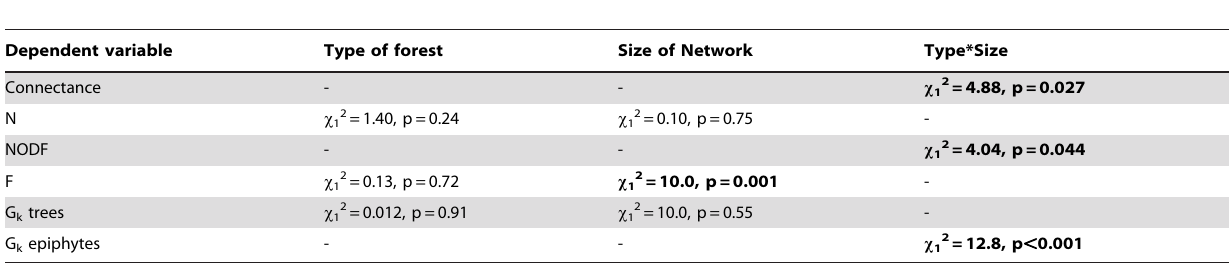
Chi-square values are the results of Likelihood Ratio Tests, with their associated P-values. Figures in bold indicate significant effects (P , 0.05).